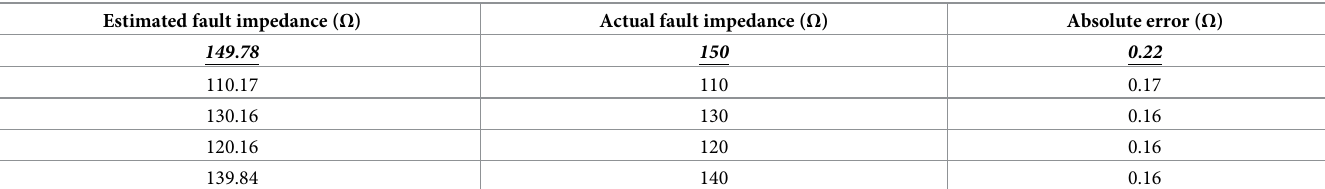
Table 11. Fault impedance estimation (AGF).